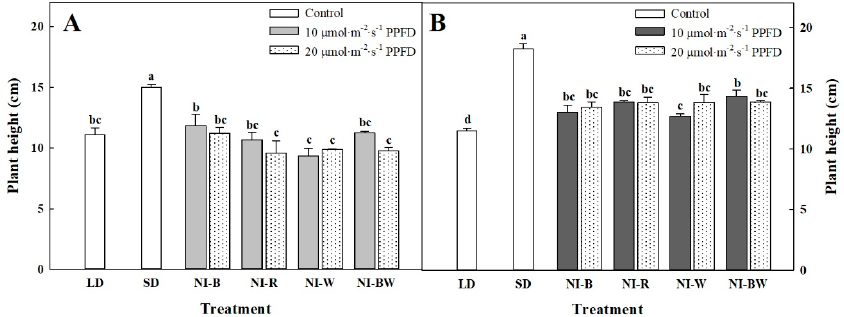
Figure 2. The effects of the night interruption light (NIL) quality at 10 or 20 μ mol·m -2 ·s -1 PPFD on height of kalanchoe ( Kalanchoe blossfeldiana ) ‘Lipstick’ (A) and ‘Spain’ (B) measured 98 and 71 days after treatment initiation, respectively. Please refer to Figure 1 for details on the NIL quality. Vertical bars indicate the means ± S.E. (n=3). Values followed by different letters are significantly different by the Duncan’s multiple range test at P ≤ 0.05.